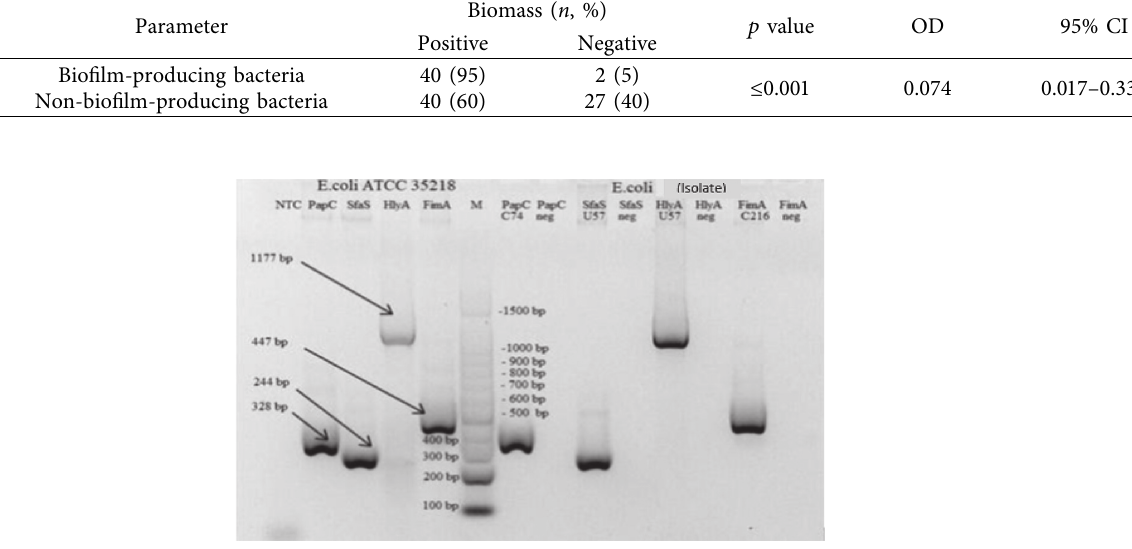
Figure 3: DNA amplification results of E. coli ATCC 35218 (left) and isolate E. coli in this study (right). FimA (447 bp), PapC (328 bp), and SfaS (244 bp)